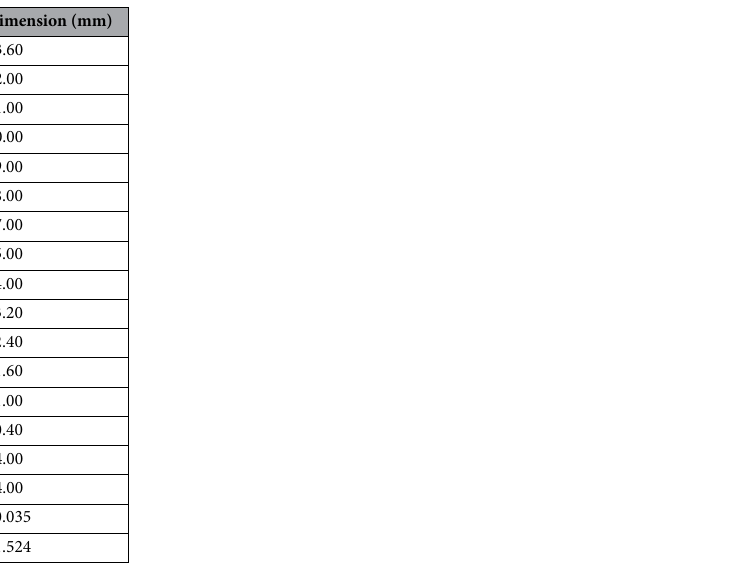
Table 1. Description of the proposed SQM design. OSR Outer square dimension of square ring, ISR inner square dimension of square